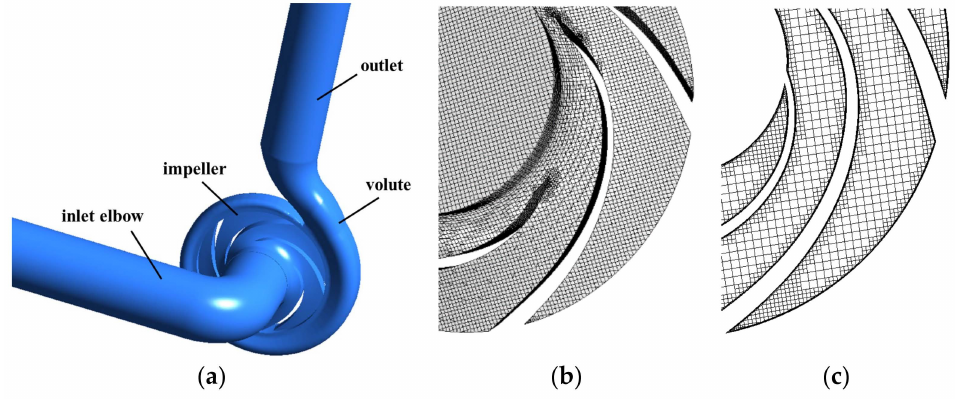
Figure 5. Computational domain. ( a ) domain composition. ( b ) volume grids. ( c ) surface